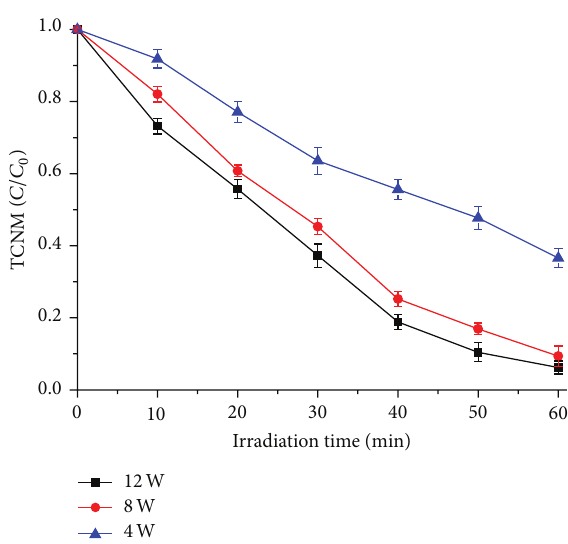
Figure 2: TCNM concentration change in the control experiments.